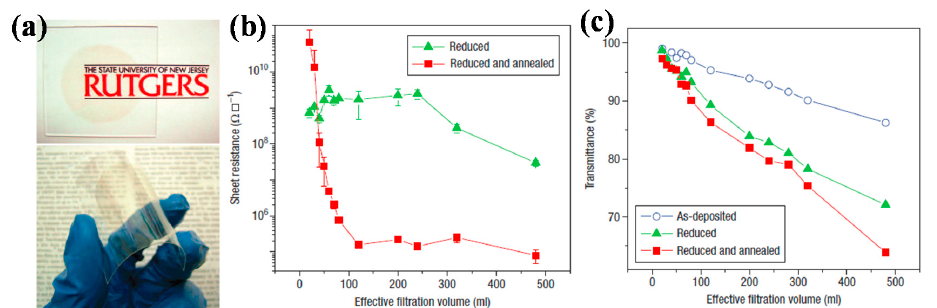
Figure 3. ( a ) Photographs of graphene oxide (GO) thin films on glass and plastic substrates; ( b ) Sheet resistance and ( c ) transmittance at 550 nm as a function of filtration volume for reduced GO thin films. Reproduced with permission from [53]; published by Nature Publishing Group, 2008.